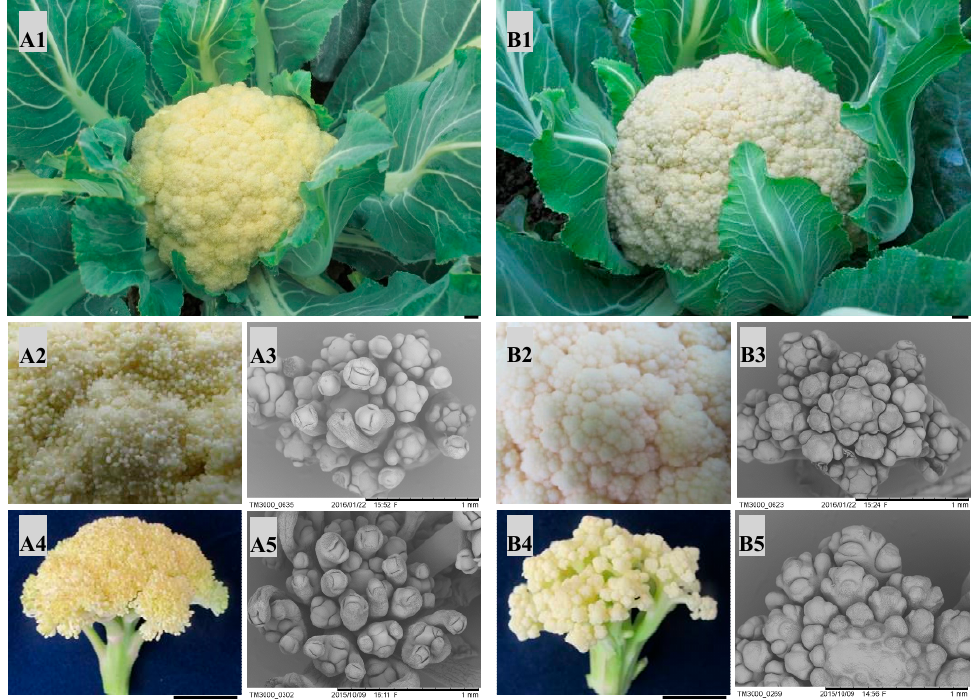
Figure 1. Phenotypic differences between” QNF11-3” ( A ) and ”QNF11-16” ( B ). A1 and B1, curds appearance at economical maturity stage; A2 and B2, enlarged view of the meristems on the curd surface at economical maturity stage; A3 and B3, electron microscope images of the surface meristems at economical maturity stage; A4 and B4, appearance of surface meristems when the plants start bolting; A5 and B5, electron microscope images of the surface meristems when the curds start bolting. The black bars in the lower right in A1, B1, A4, and B4 indicate 1 cm, and those in A3, B3, A5, and B5 indicate 1 mm.